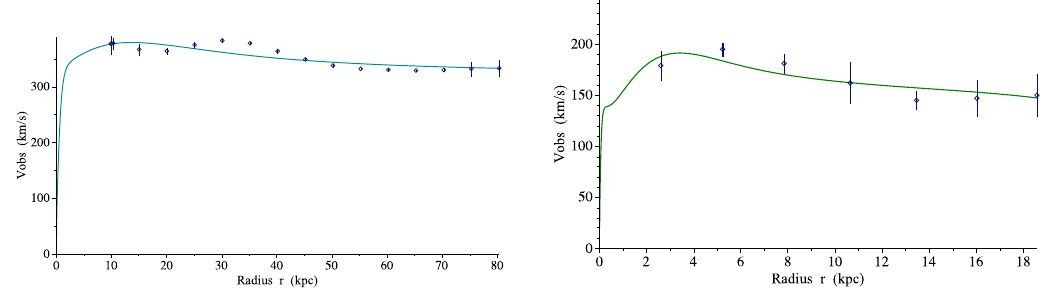
Figure 8. From left to right : UGC02487—Type S0A, SBbulge ( r ) ≠ 0, ( α , β ) = ( 19.4404,1.2193 ) . NGC4138 - Type S0A, SBbulge ( r ) ≠ 0, ( α , β ) = ( 5.5141,0.7475 ) .